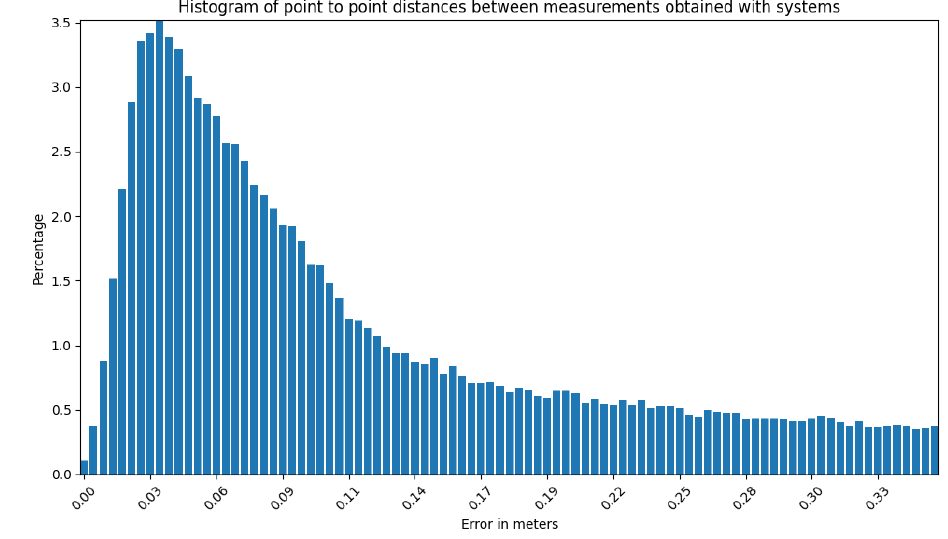
Figure 12. Histogram showing the distribution of distances from our system to reference Velodyne VLP 16. It can be seen the majority are below 10